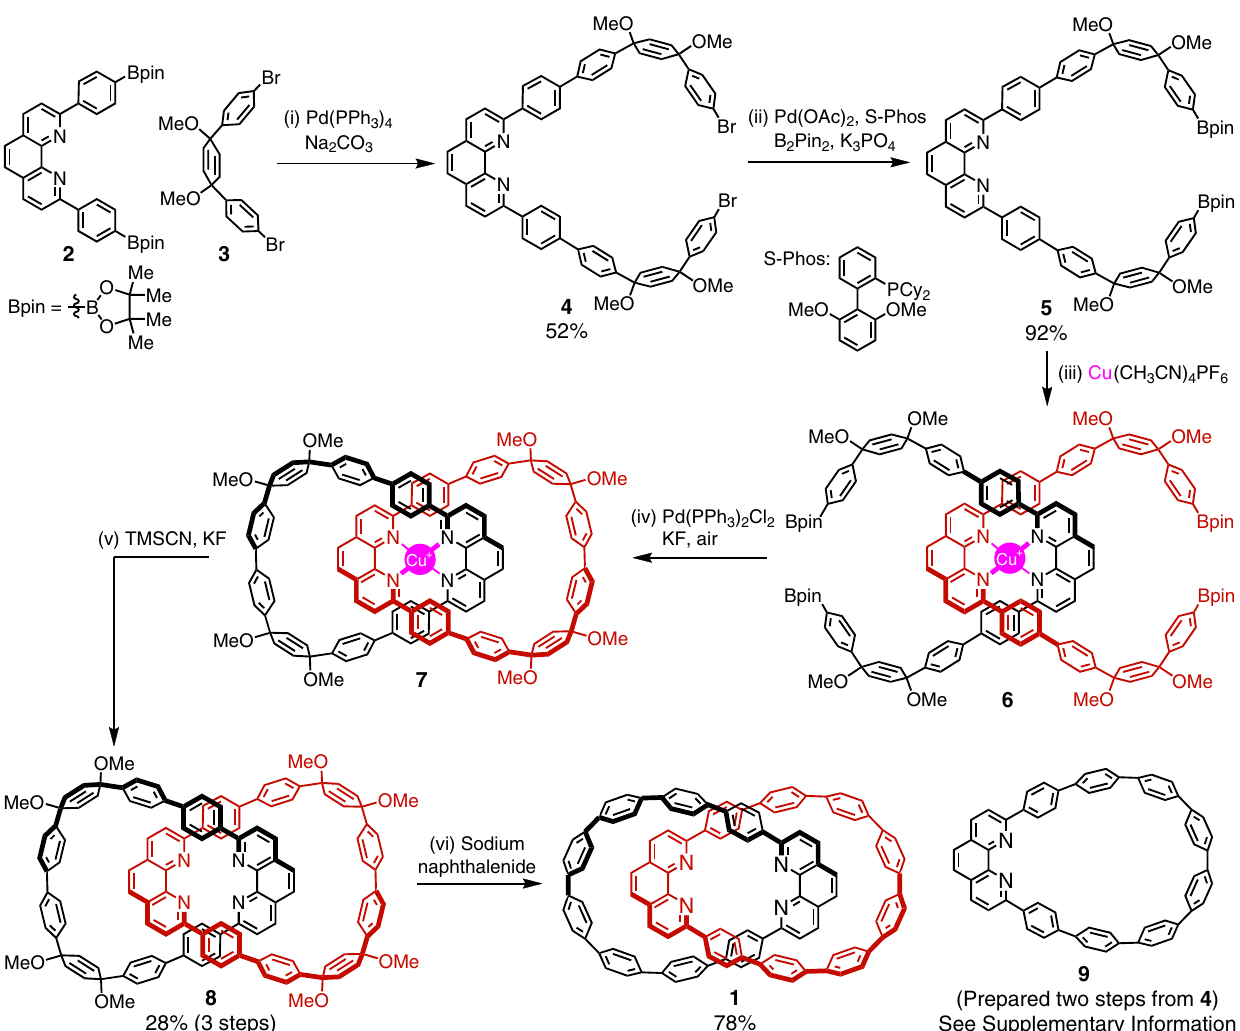
Fig. 2 Synthetic routes to catenane 1 . The reaction conditions were as follows: (i) 2 (1 equiv), 3 (2.5 equiv), Pd(PPh 3 ) 4 (10 mol%), Na 2 CO 3 (20 equiv), and toluene/water, 100 o C, 24 h. (ii) 4 (1 equiv), B 2 pin 2 (4 equiv), Pd(OAc) 2 (10 mol%), S-Phos (20 mol%), K 3 PO 4 (6 equiv), and 1,4-dioxane, 85 o C, 24 h. (iii) 5 (1 equiv), Cu(CH 3 CN) 4 PF 6 (0.5 equiv), and THF, 25 o C, 10 min. (iv) Crude 6 in solution, Pd(PPh 3 ) 2 Cl 2 (1 equiv), KF (20 equiv), and THF/H 2 O, 25 o C, 24 h. (v) Crude product 7 , TMSCN (10 equiv), KF (15 equiv), and CH 2 Cl 2 /CH 3 CN/H 2 O, 25 o C, 6 h. (vi) 8 (1 equiv), THF, and freshly prepared sodium naphthalenide (0.2 M solution in THF, 15 equiv), – 78 o C, 1.5 h. Bpin boronic acid pinacol ester, Me methyl, Ph phenyl, Cy cyclohexyl, TMS